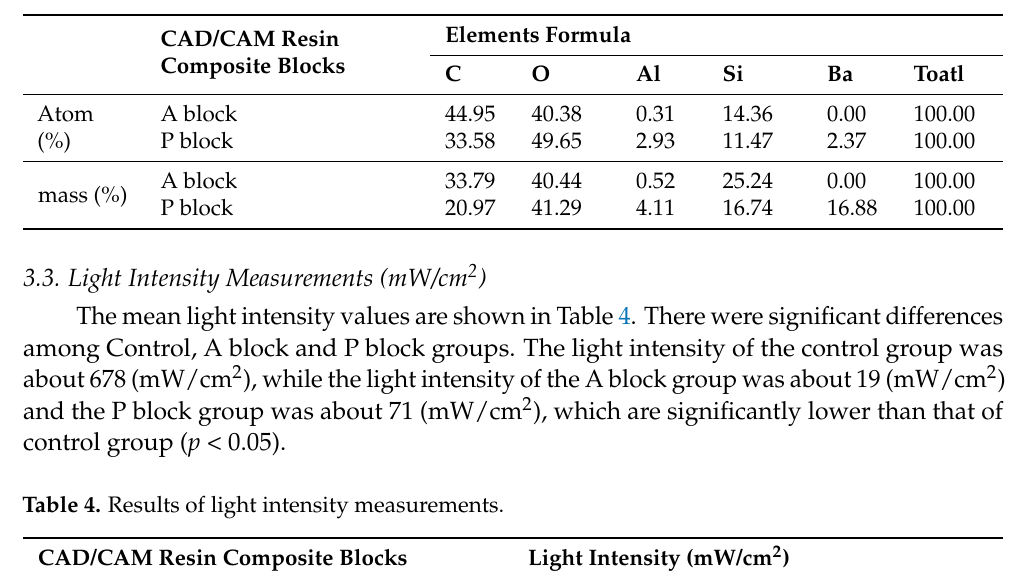
Figure 2. Results of the typical SEM analysis. SEM observation of CRB surface at 5000 × magnification after alumina air abrasion at 0.2 MPa: A block ( A ) and P block ( B ). Many nano-dimples were observed on the surface of A block, and many micro-irregular dimples were observed on the surface of P block. Table 3. Results of EDS analysis on the surface of CAD/CAM resin composite blocks after alumina air abrasion.